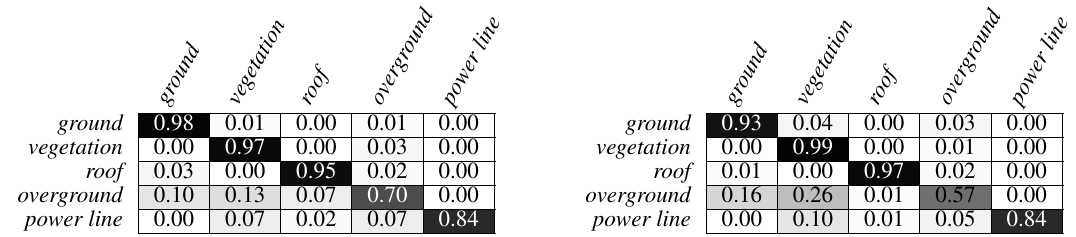
Figure 4. Confusion matrices, normalized per rows. Left: results achieved in urban and flat areas. Right: accuracy assessment in mountainous environments.